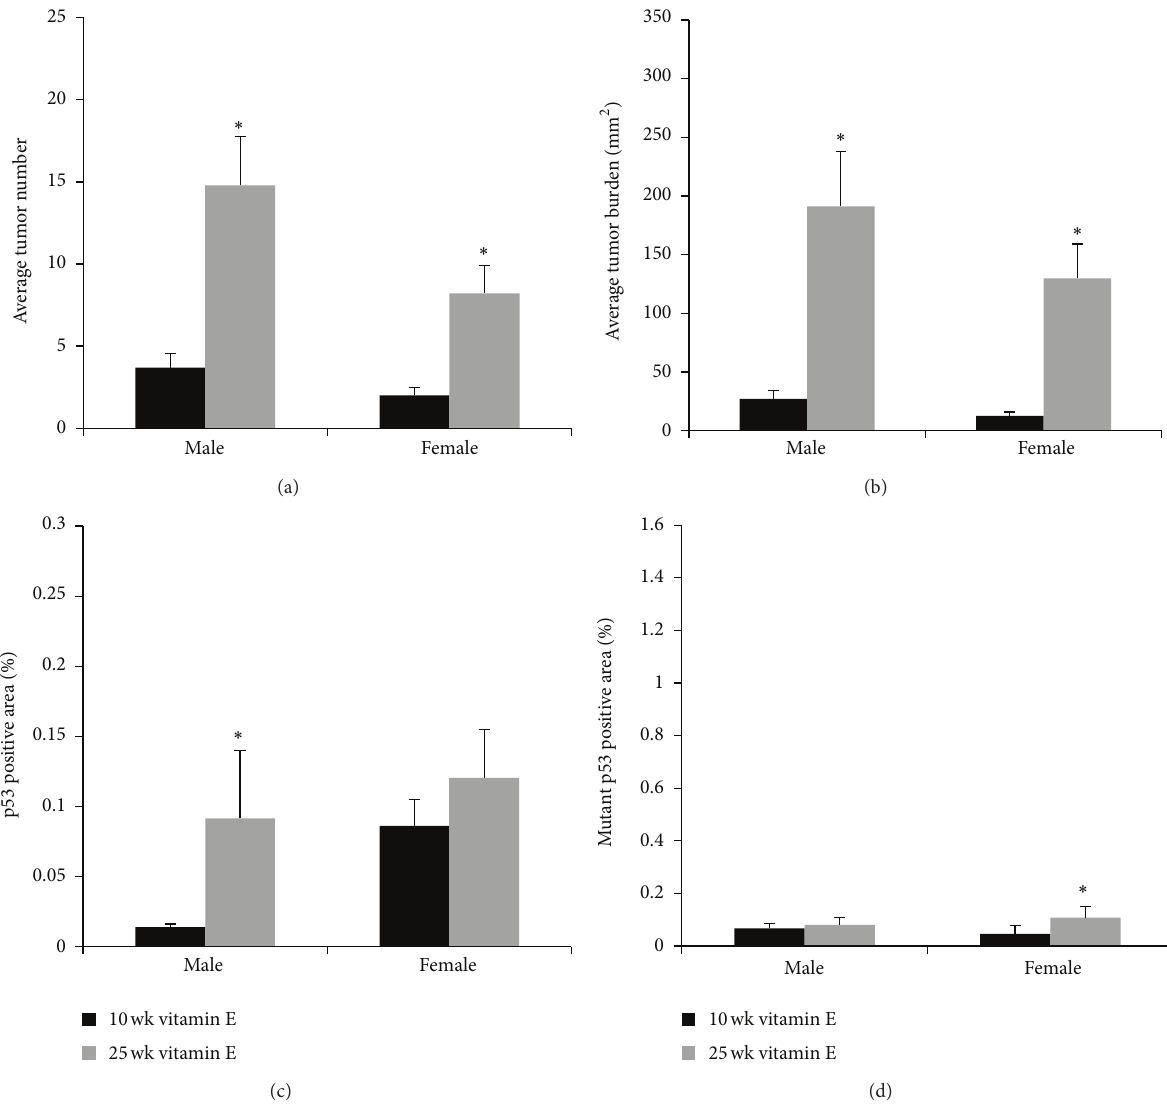
Figure 4: Efficacy of vitamin E on tumor number, burden, and p53 status in male and female mice. (a) Male and female mice treated with topical vitamin E developed more tumors in the 25-week compared to the 10-week model ( ∗ 𝑃 < 0.0001 ). (b) Male and female mice treated with topical vitamin E exhibited increased tumor burden in the 25- compared to the 10-week model ( ∗ 𝑃 < 0.0001 ). (c) Male mice treated with vitamin E exhibited increased epidermal p53-positive area in the 25- compared to the 10-week model ( ∗ 𝑃 = 0.0023 ). (d) Female mice treated with vitamin E exhibited significantly increased epidermal mutant p53-positive area in the 25- compared to the 10-week model ( ∗ 𝑃 = 0.0134 ). Error bars = mean+/ −